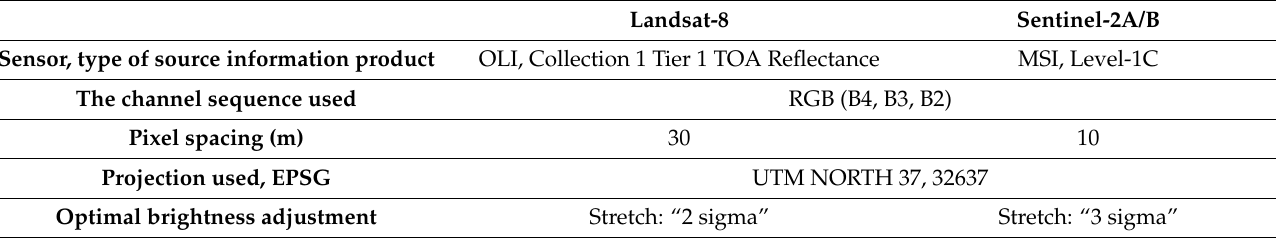
Table 1. The main features of satellite image preprocessing.